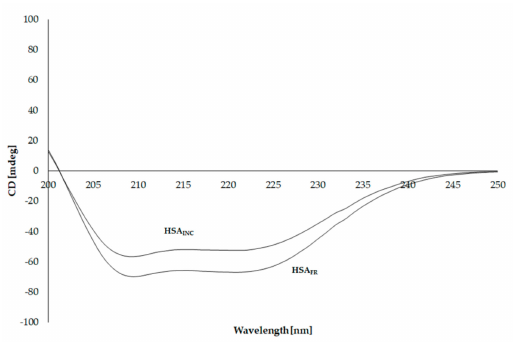
Figure 5. CD spectra of 3 × 10 − 6 mol · L − 1 HSA FR and HSA INC .